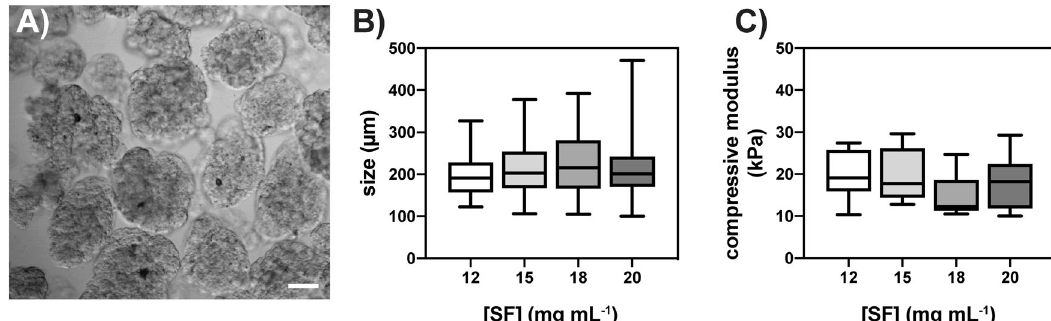
Fig. 3 Morphological and mechanical characterization of SF µgels. A Digital picture of the 30 MB SF µgels (SF: 15 mg mL − 1 ) imaged through an optical microscope. Scale bar = 50 µm. Morphological and mechanical characterization of SF µgels prepared in PBS at different SF concentrations: ( B ) size distribution; ( C ) compressive (elastic)